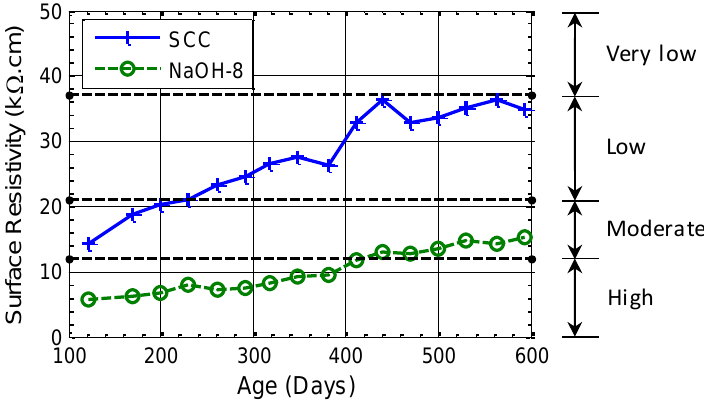
Figure 12. Effect of ASR on surface resistivity: NaOH-8 and SCC from the larger batch series. Note that the horizontal dashed lines are the limits in AASHTO TP 95-14 [59].